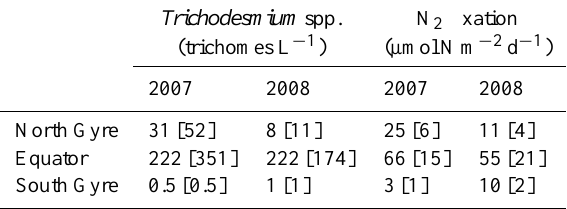
Fig. 6. Latitudinal and vertical distribution of chlorophyll- a con- centration during the 2007 (a) and 2008 (b) cruises. Table 1. Mean Trichodesmium spp. surface abundance and inte- grated N 2 fixation rate on each region during the 2007 and 2008 cruises. Standard deviation is indicated in brackets.